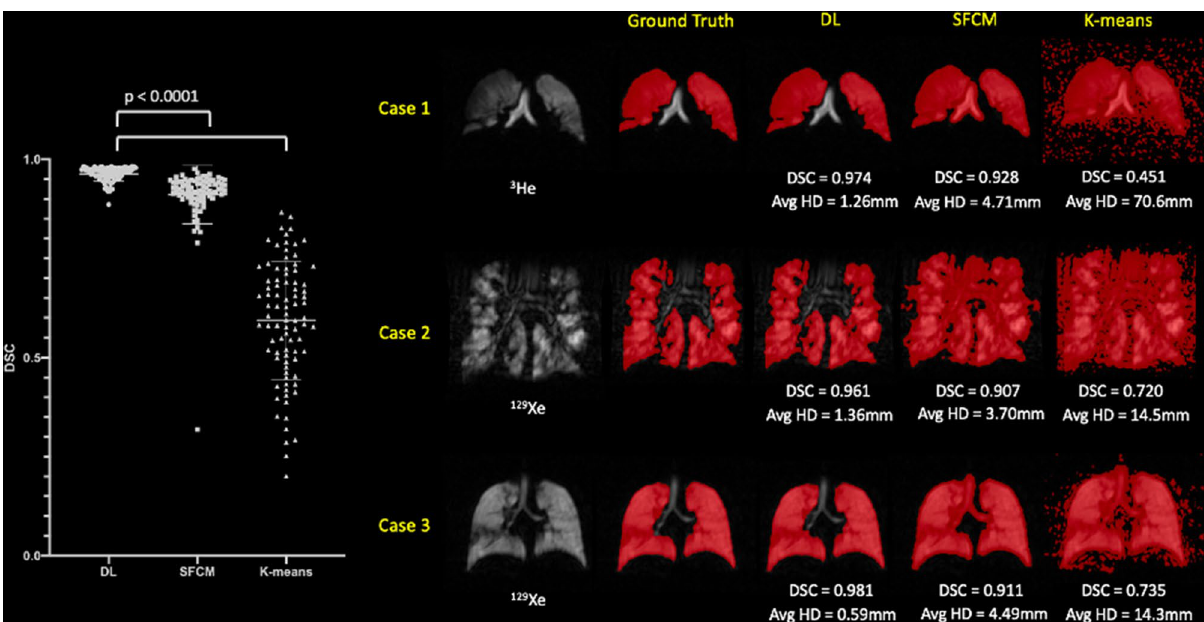
Figure 6. Comparison of performance on testing scans between the combined 129 Xe and 3 He DL method and conventional segmentation methods (SFCM and K-means) with P-values for Friedman tests with Bonferroni correction for multiple comparisons. Mean and standard deviation values are marked by a bold line and whiskers, respectively. Individual DSC and Avg HD values for each method are displayed for three